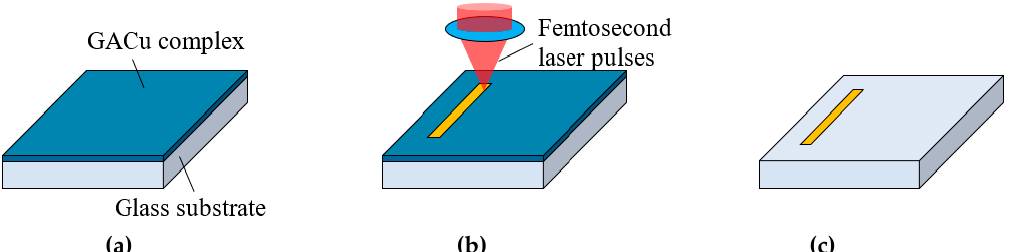
Figure 1. ( a ) Spin-coating of a glyoxylic acid Cu (GACu) complex film on a glass substrate. ( b ) Femtosecond-laser direct writing by reduction of the GACu complex film. ( c ) Nonirradiated GACu complex removed by rinsing the substrate with ethanol.